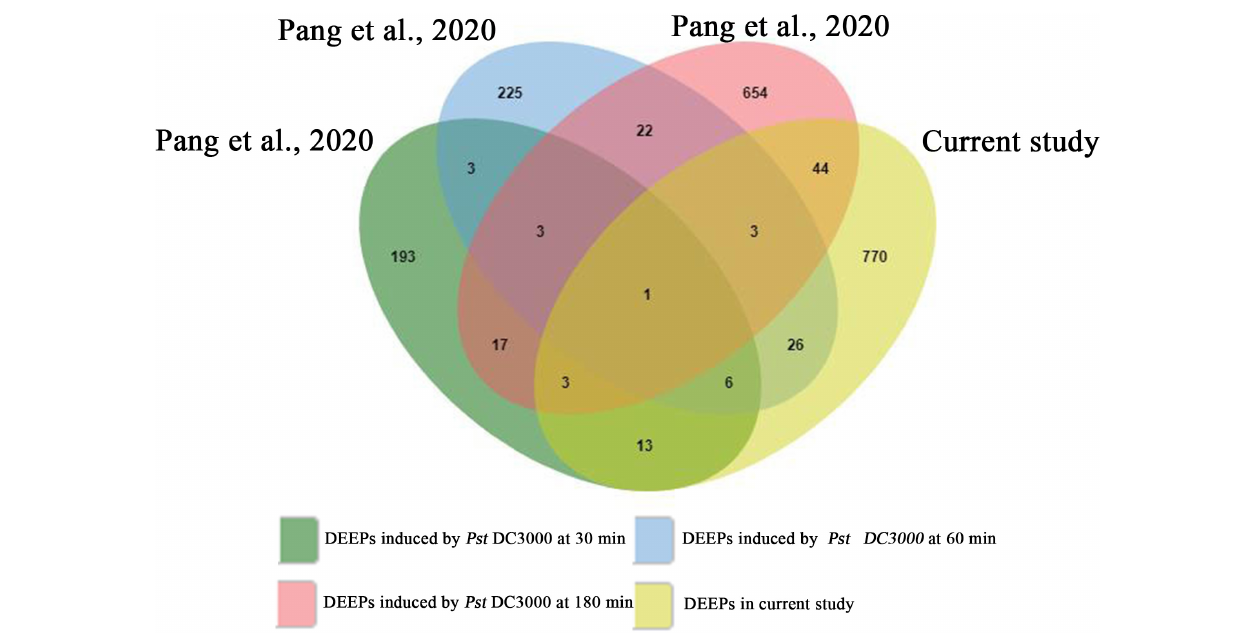
FIGURE 8 | Venn diagram showing the overlapping phosphoproteins from previously published stomatal immune response-related phosphoproteomics and the present study. DEEPs, differentially expressed phosphoproteins.